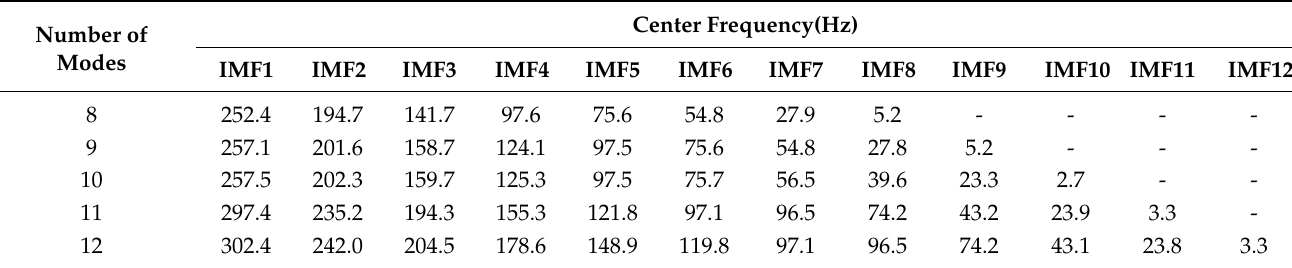
Table 2. Center frequencies corresponding to different modal numbers.